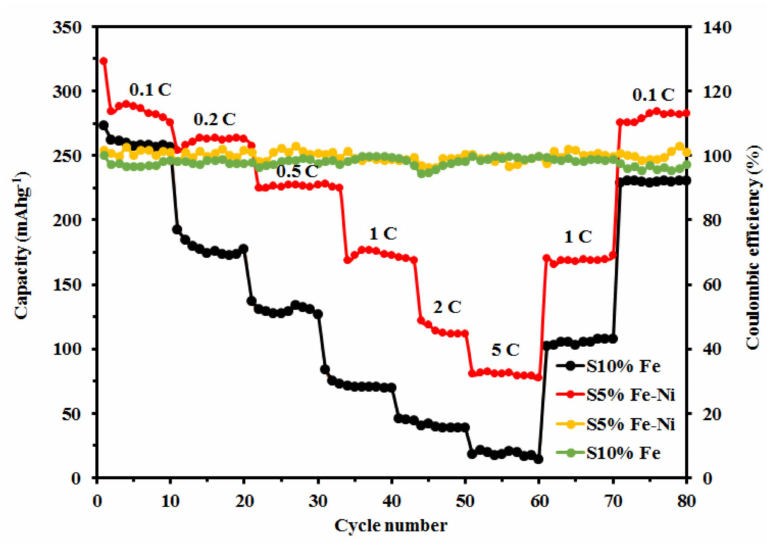
Figure 6. The rate capabilities and Coulombic efficiencies of the S5% Fe-Ni and S10% Fe